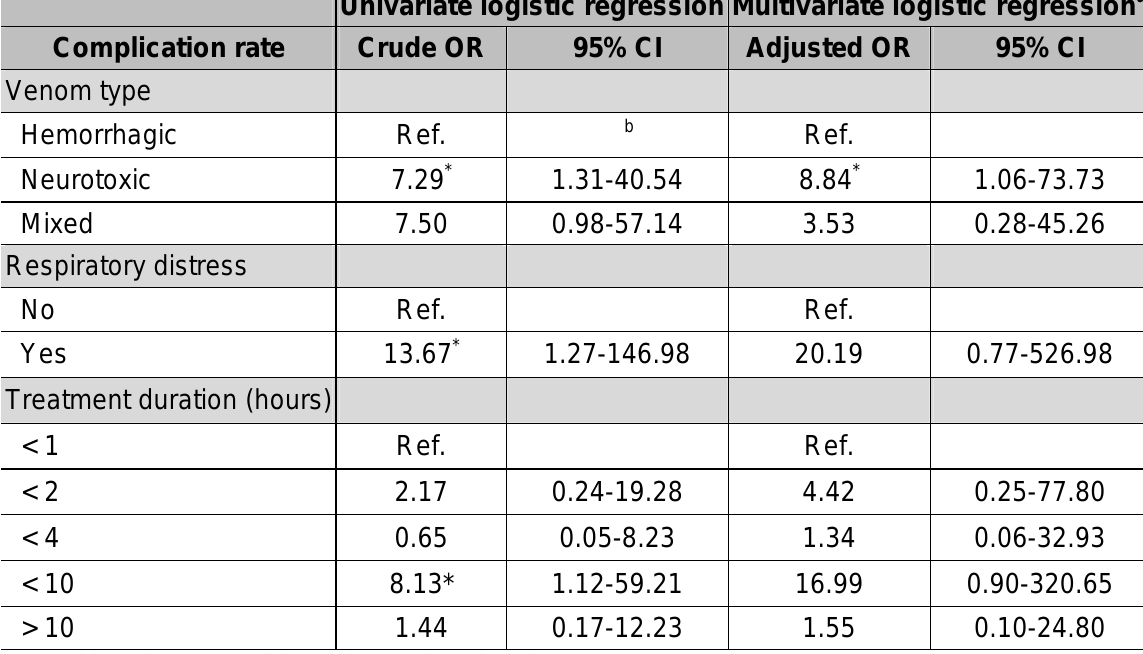
Table 2. Logistic regression analysis of complications derived from 58 cases of venomous snake bites, the medical center of Taiwan, January 1993 to December